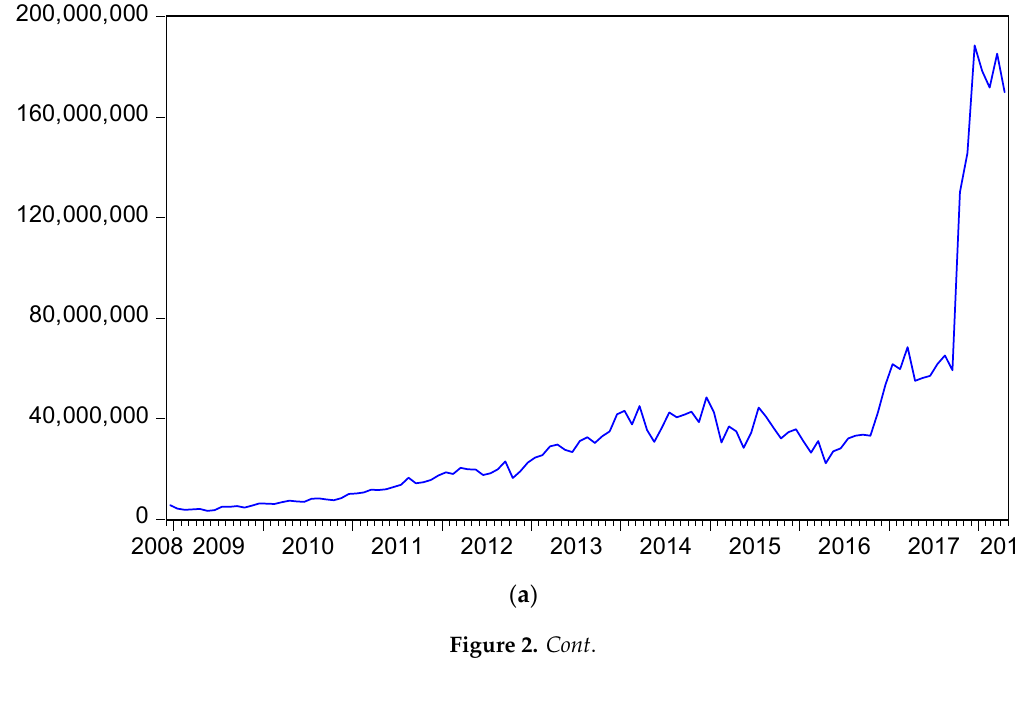
Figure 1. ( a ) Forecast of log(𝐸) ( ±2 standard errors) . ( b ). Forecast of log(E) (cid:2903)(cid:2885) ( ± 2 standard errors) .